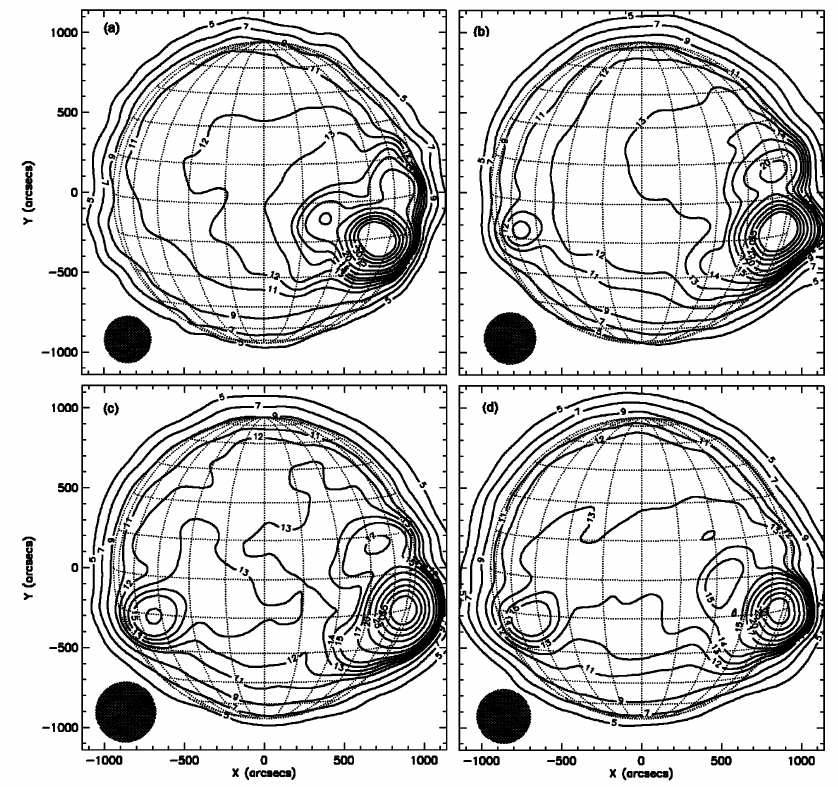
Fig. 4. Stokes I parameter maps of solar emission (a) at 3.41 cm on 2012-07-16, UT 14:18, (b) at 3.76 cm on 2012-07-17, UT 7:15, (c) at 4.44 cm on 2012-07-17, UT 9:10 and (d) at 3.97 cm on 2012-07-18, UT 13:30. Levels are presented in 10 3 K. Dark spots present the antenna pattern HPBW at the corresponding